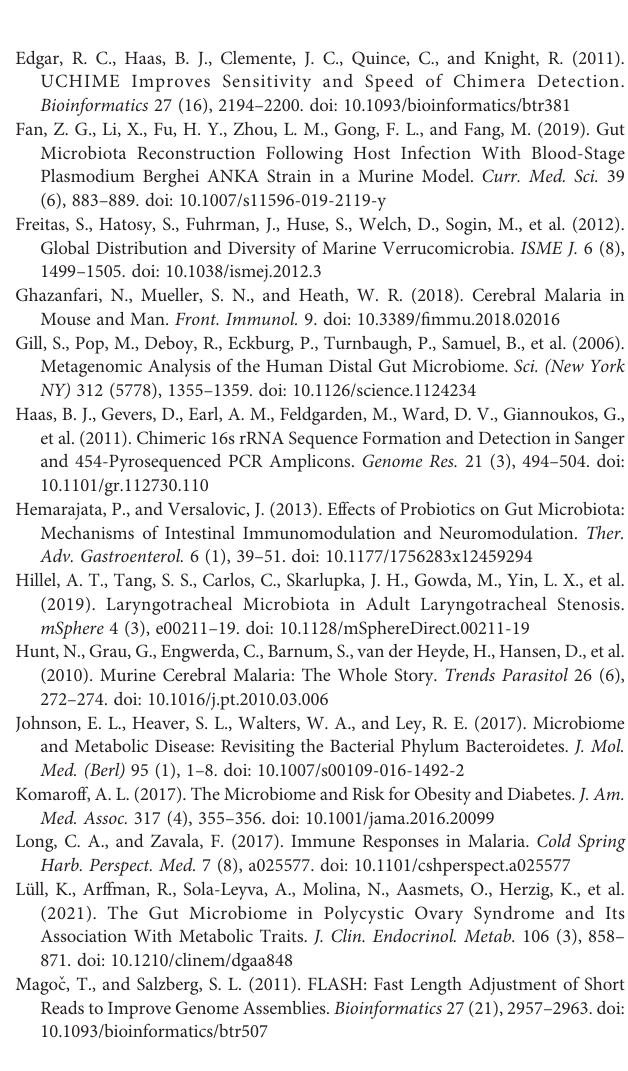
Supplementary Figure 4 | OTU co-abundance network showing modules of OTUs at the genus level. Different nodes represent different genera, and node size represents the average relative abundance of the genus, nodes of the same phylum have the same color, the thickness of the connecting line between the nodes is positively correlated with the absolute value of the correlation coef fi cient of species interaction, and the color of the connecting line is positively correlated with the correlation (Red is positively correlated, blue is negatively correlated). Supplementary Table 1 | Within- versus Among-Group Dissimilarities analysis via Analysis of Similarities (ANOSIM). R-value is between (-1, 1), and when the R- value is greater than 0, it indicates signi fi cant differences between groups. The credibility of the statistical analysis is expressed by the P-value, and P<0.05 indicates statistical signi fi cance. Signi fi cance < 0.05 indicates a signi fi cant difference. Supplementary Table 2 | Within- versus Among-Group Dissimilarities analysis via the Multi Response Permutation Procedure (MRPP). A smaller value of the observed delta indicates that the difference within the group is lower; a larger value of the expected delta indicates that the difference between the groups is higher; A > 0 demonstrates that the difference between the groups is higherthan that within the groups; A < 0 indicates that the difference within the groups is higher than that between the groups. P < 0.05 indicates a signi fi cant